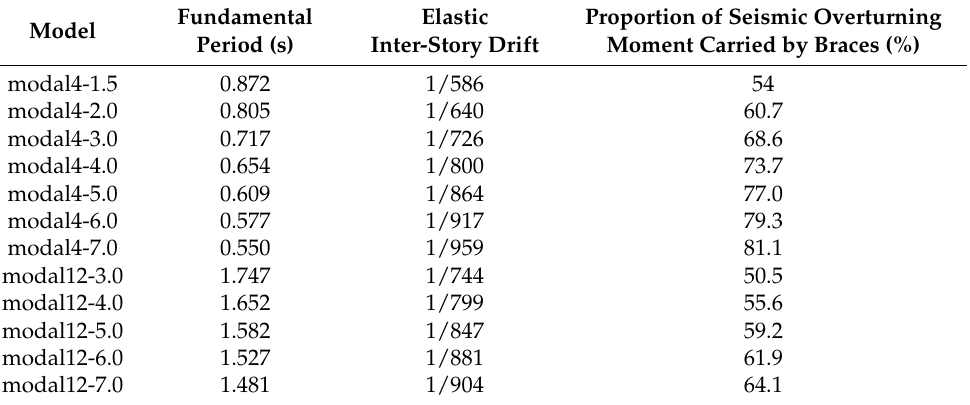
Table 9. Overall information of PCF-BRB structure.